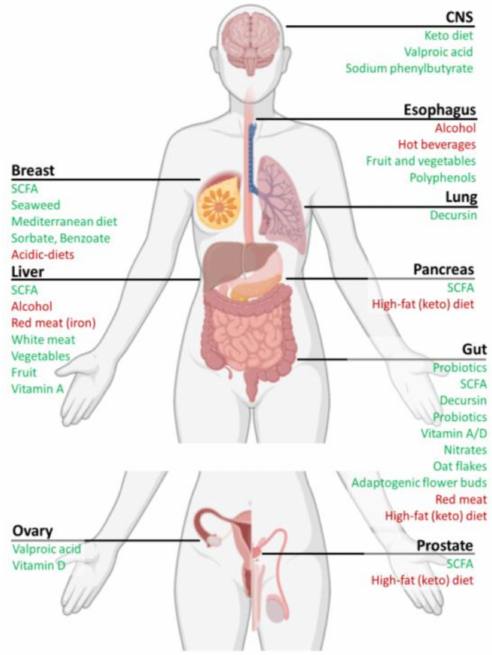
Figure 1. Cancer promoting and preventative interactions of dietary factors and organ systems. Intake of dietary factors, as demonstrated only by more recent research studies, can affect cancer progression through positive (green) or negative (red) effects on organ systems, as indicated. Details are further highlighted in Table